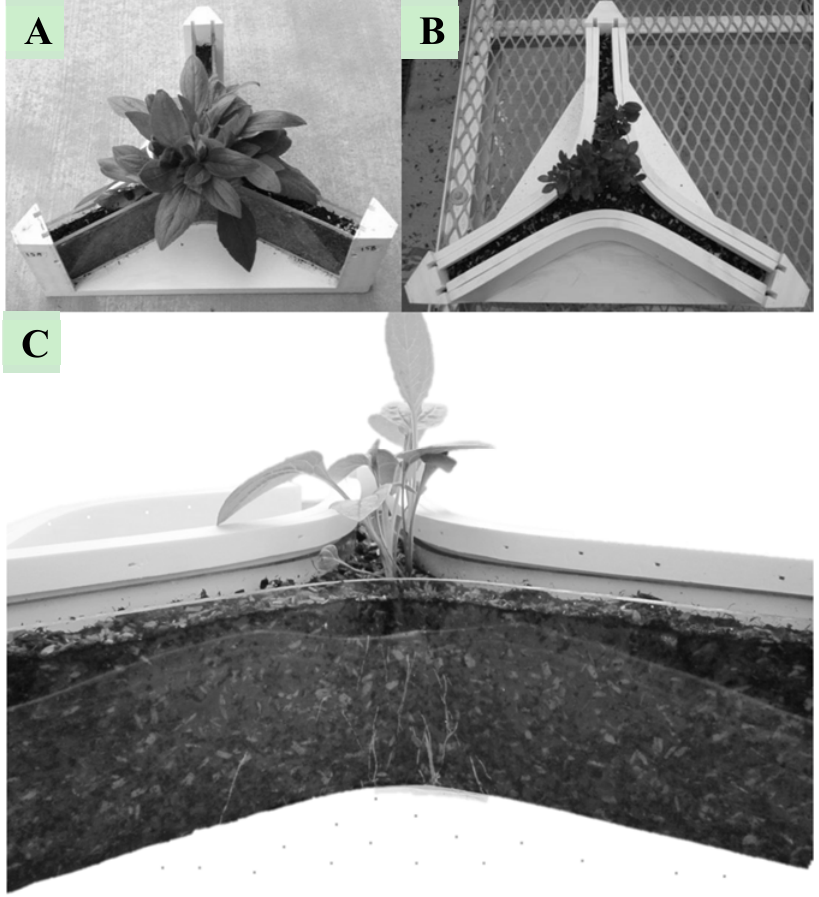
Figure 2. ( A ) Mini-Horhizotron with a Rudbeckia hirta plant, transplanted from a plug, with all shade panels removed; ( B ) All shade panels in place on the mini-Horhizotron, blocking out sunlight from the Ilex crenata rhizosphere; ( C ) Side view of the mini-Horhizotron with visible Rudbeckia roots growing in the